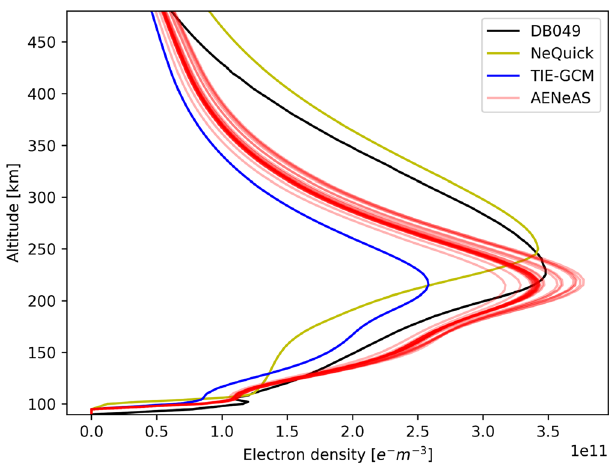
Fig. 8. Example electron density pro fi les. Observed pro fi le (DB049) is from Dourbes, Belgium at 1230, 5 June 2017. Pro fi les from TIE- GCM, NeQuick and each individual AENeAS member is plotted.